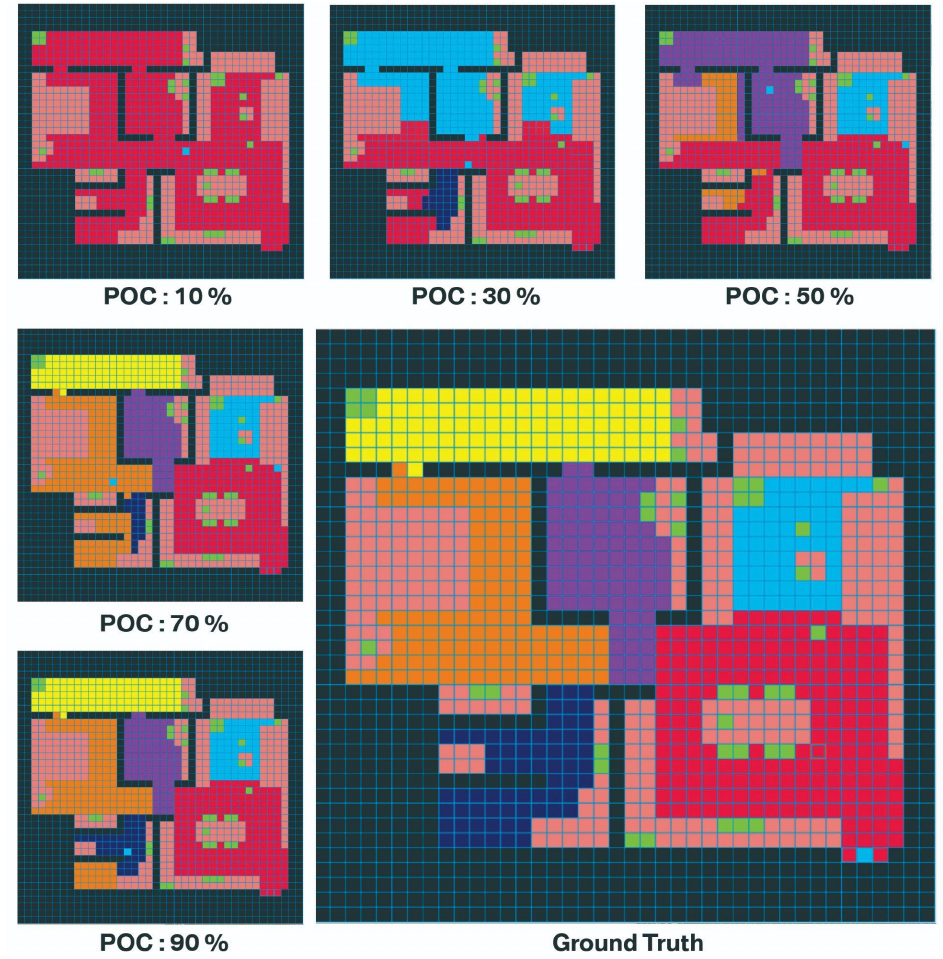
Figure 7. The result of section segmentation for different POC in the computer program visualization. The color blocks representation can be found at Figure 5.